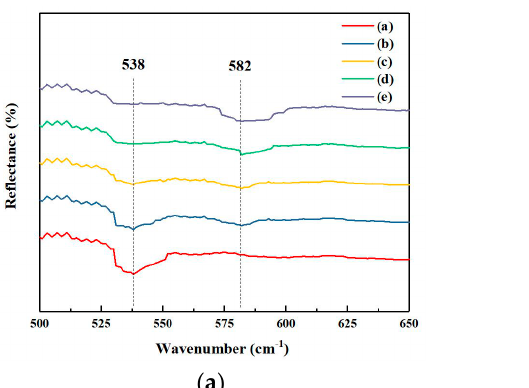
Figure 2. ( a ) FTIR of the Mn-Ni-O electrodes; ( b ) Infrared spectra of OH groups on samples surface. Samples (a), (b), (c), (d), and (e) denote the samples with electroplating Mn: Ni ratio of 1:0, 1:0.25, 1:0.67, 1:4, and 0:1, respectively.